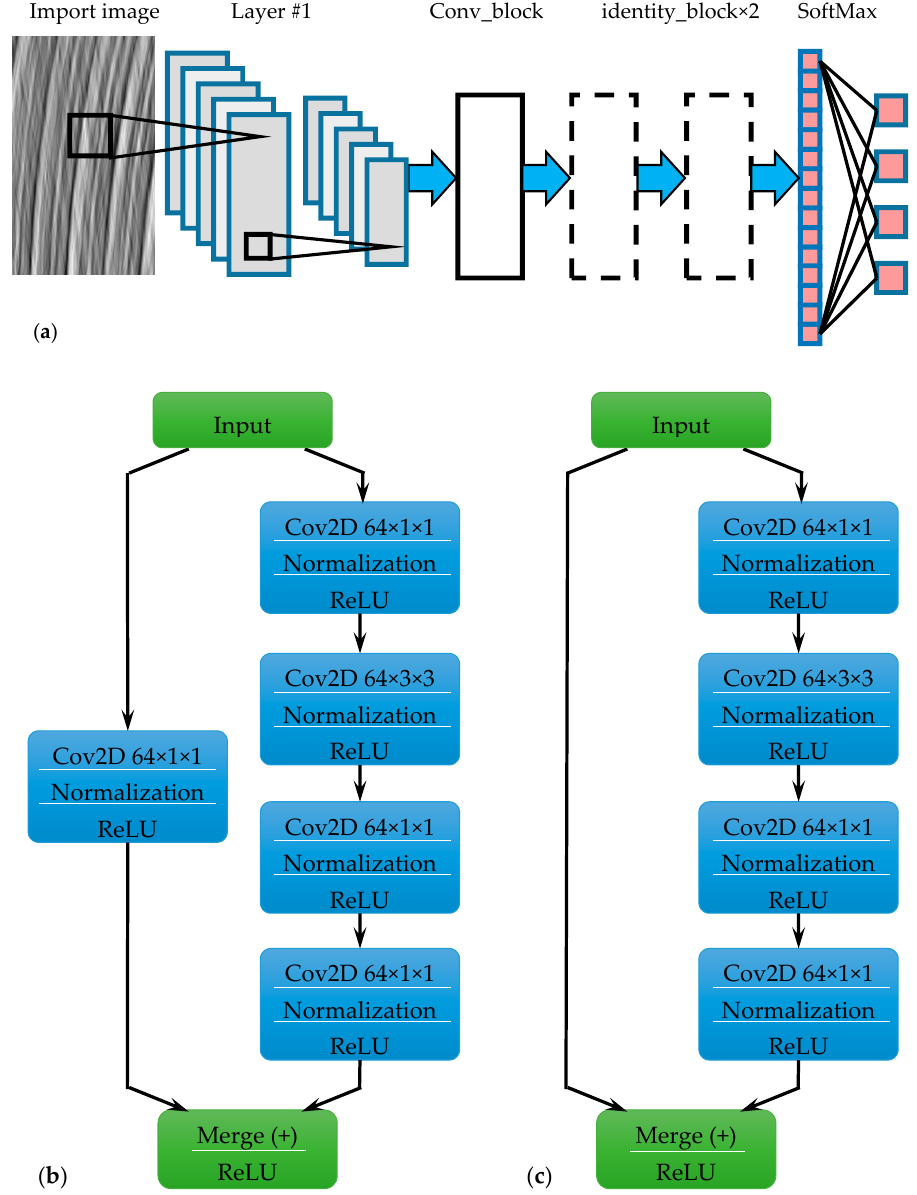
Figure 9. Schematic of network: ( a ) network architectures; ( b ) convolutional identity block; and ( c ) identity